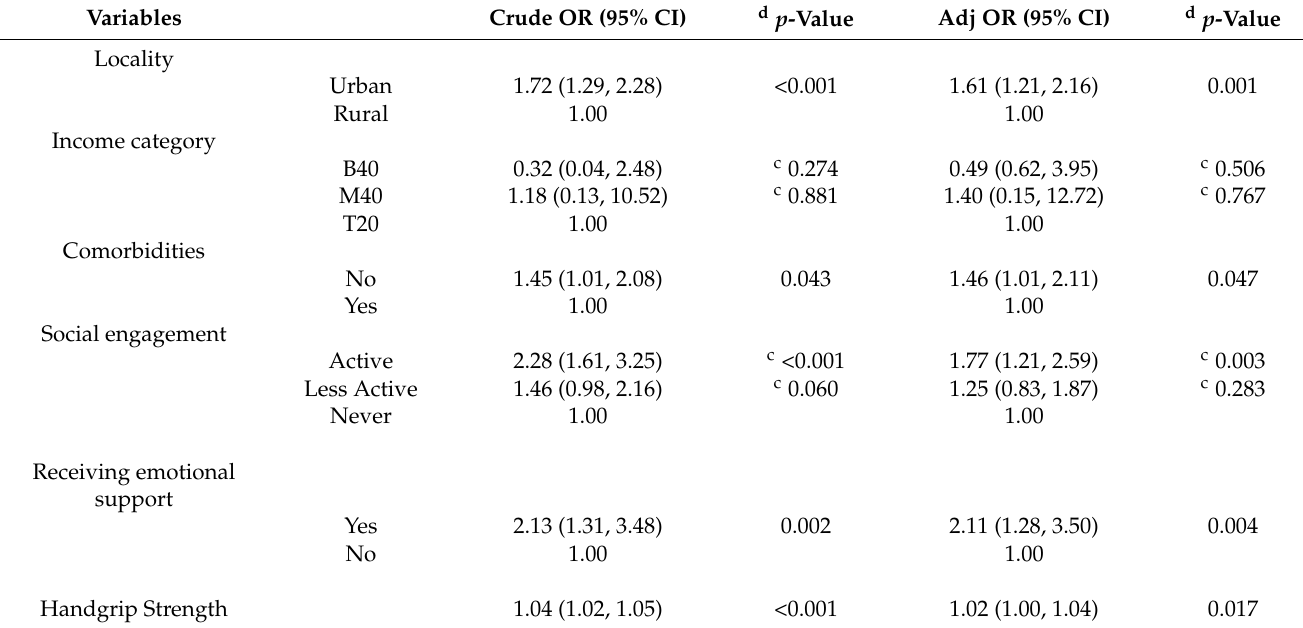
Table 4. Factors associated with